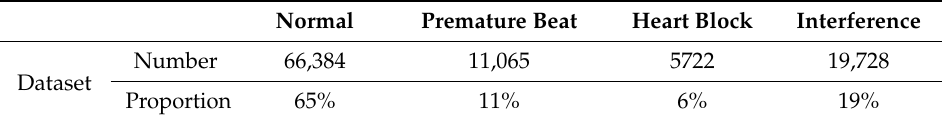
Table 1. Data distribution of electrocardiogram (ECG)